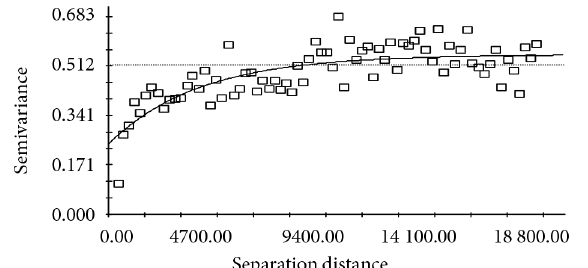
Fig. 4. Variogram model for PI almost normal distribution of input data shown in Fig- ure 3 is related to this subject.